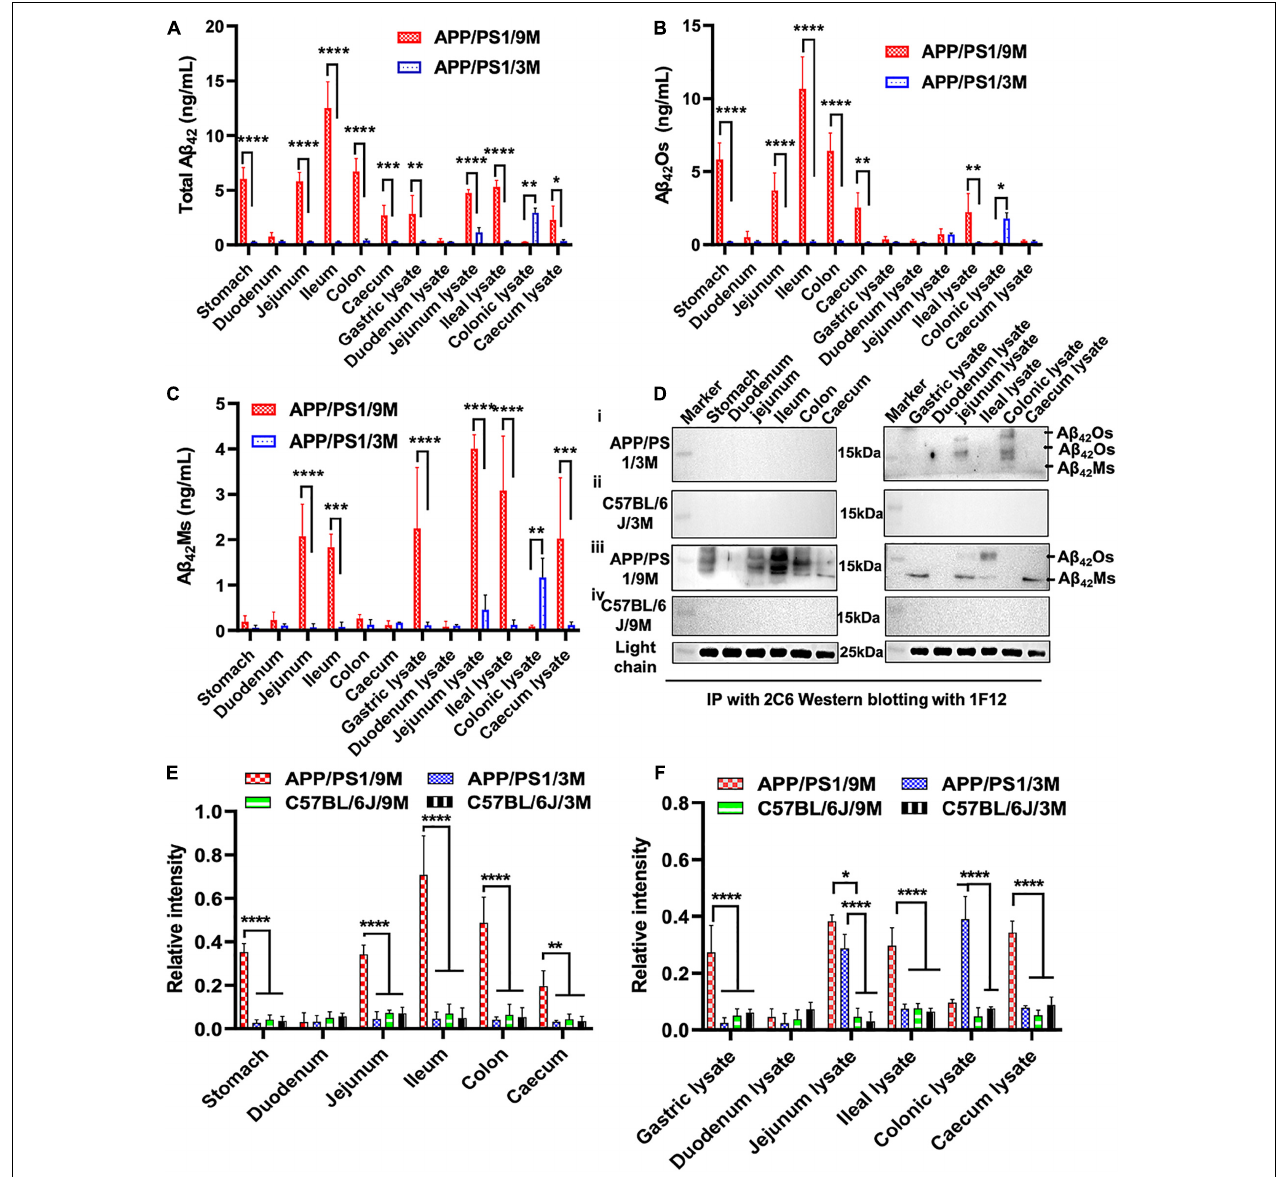
FIGURE 4 | Dynamic changes in the levels of A β 42 Ms and A β 42 Os in the intestines were detected and quantified via 1F12/2C6 and 1F12/1F12 ELISA. The level of total A β 42 , A β 42 Os, and A β 42 Ms in the stomach, duodenum, jejunum, ileum, colon, and cecum and their lysates from 3-month-old APP/PS1 ( n = 4; A–C ), 9-month-old APP/PS1 ( n = 4; A–C ). (D) Representative IP-Western blotting data to analyze the distribution of A β 42 in the stomach, duodenum, jejunum, ileum, colon, and cecum and their lysates from 3-month-old APP/PS1 (i), 9-month-old APP/PS1 (iii), and C57BL/6J mice (ii,iv) at the same ages. (E,F) The Western blotting results for A β 42 in APP/PS1 or C57BL/6J mice were quantified. Data are presented as means ± SEM. Two-way analysis of variance (ANOVA) was used for multigroup comparisons. Statistical significance is indicated in the figures by * p < 0.05, ** p < 0.01, *** p < 0.001, and **** p <